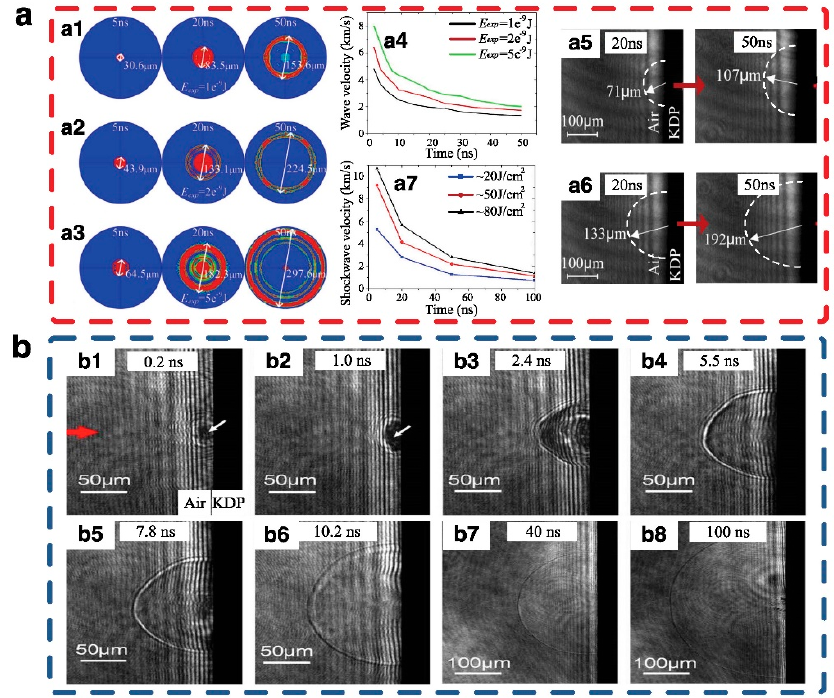
Figure 18. The evolution diagram of shock wave. ( a ) Air shockwave propagation under different explosion conditions. a1 , a2, and a3 are the simulated condition that E exp = 1e − 9 , E exp = 2e − 9 , and E exp = 5e − 9 , respectively, with a4 the influence of explosion energy on the shockwave velocity. a5 and a6 are the time-resolved image series of laser-induced KDP surface damage process with fluences 20 J / cm 2 and 50 J / cm 2 , respectively, and a7 the shockwave velocity [90,93]; ( b ) The propagation of shockwave in pump laser pulse duration from 0.2 ns to 100 ns [69].